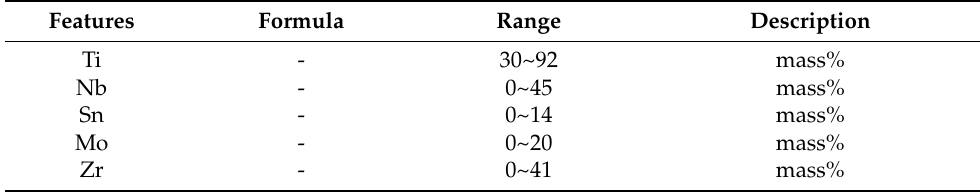
Table 1. A total of 33 features used to build the machine learning models.